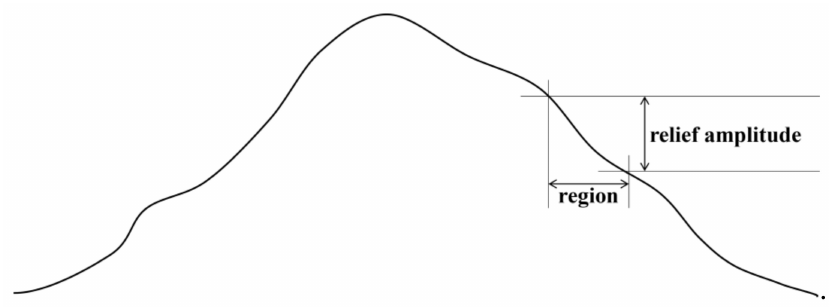
Figure 2. Relief amplitude diagram for given